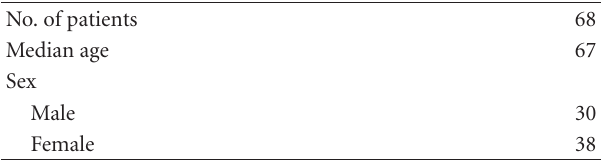
Table 1: Clinical features of patients